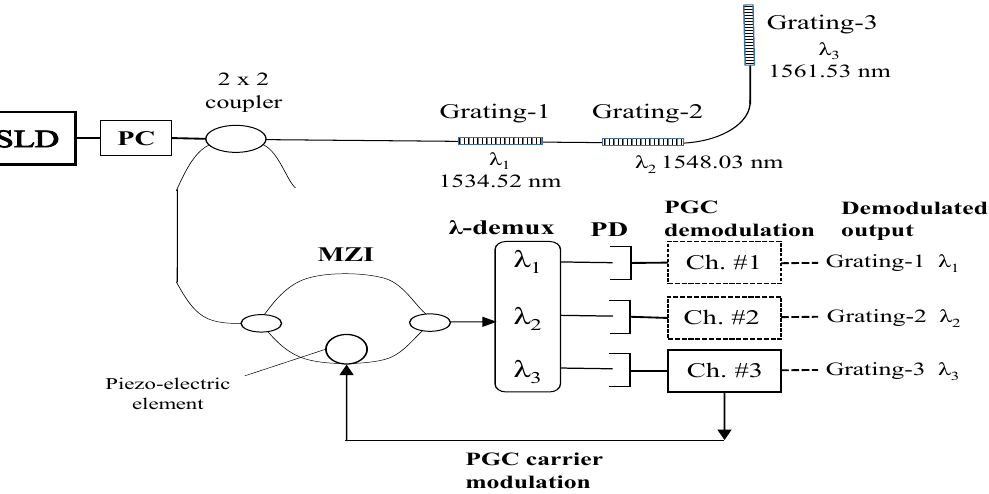
Figure 7. Proposed testing set-up using wavelength demultiplexer and unbalanced Mach–Zehnder interferometer.